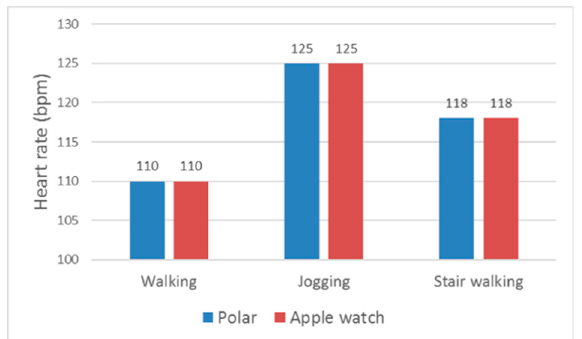
Figure 4. Mean heart rate value for the Apple watch and Polar H10 on three different activities: walking, jogging and stair